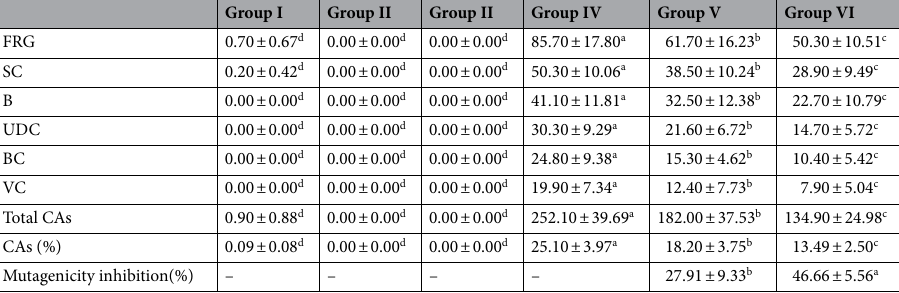
Table 5. Frequencies of chromosomal abnormalities caused by pendimethalin and the protective role of curcumin. Group I: tap water (control), Group II: 5 mg/L curcumin, Group III: 10 mg/L curcumin, Group IV: 12 mg/L pendimethalin, Group V: 12 mg/L pendimethalin + 5 mg/L curcumin, Group VI: 12 mg/L pendimethalin + 10 mg/L curcumin. Data are shown as mean ± standard deviation (SD). The averages shown with different letters in the same line are statistically significant (P < 0.05). FRG: Fragment, SC: Sticky chromosome, B: Bridge, UDC: Unequal distribution of chromatin, BC: binucleated cell, VC: vagrant chromosome.